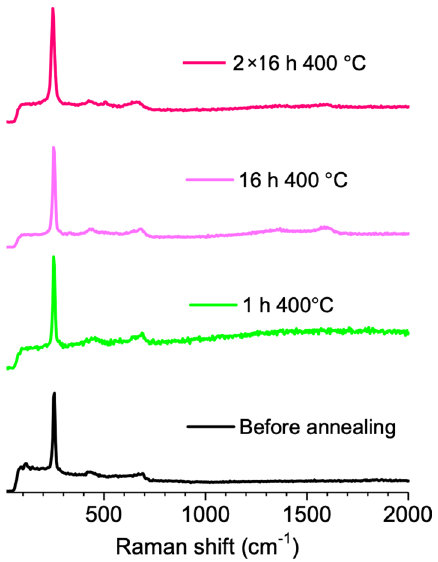
Fig. 8 Raman spectra measured from replicas Mg 2 Si pieces made of 92% of Mg 2 Si and 8% of solution of PVDF in DMF before and after sintering performed at 400 °C of different durations: 1 h, 16 h and 32 h. Black and green curves correspond to one sample before and after sintering and pink curves correspond to another sample, first sintered by 16 h and next to another 16 h sintering (the 32 h were not